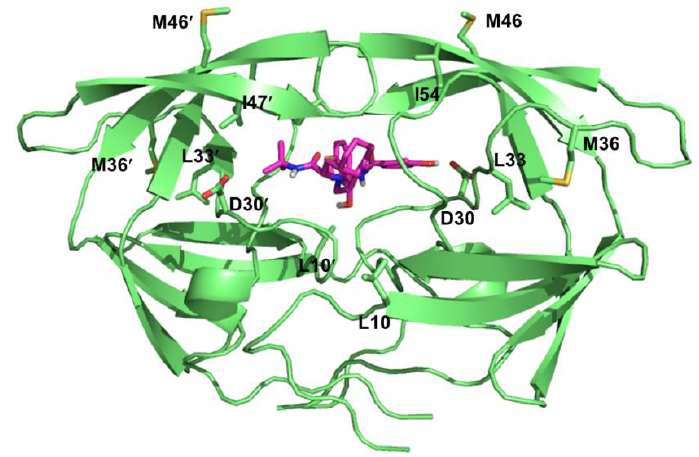
Figure 6. Detailed view of the protease inhibitor binding pocket. Nelfinavir (NFV) is shown as magenta sticks and the NFV-resistant mutation sites are shown in green sticks. PDB 1OHR